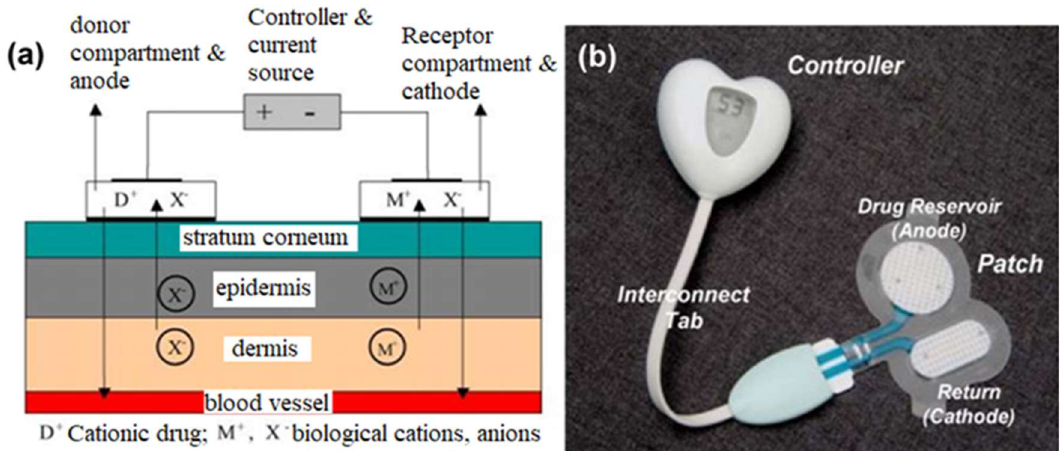
Figure 3. ( a ) An iontophoretic drug delivery system comprising donor and receptor compartments along with a current source and controller. D + : cationic drug; M + : biological cations; X − : biological anions. ( b ) Vyteris Inc. LidoSite TM topical system [18].